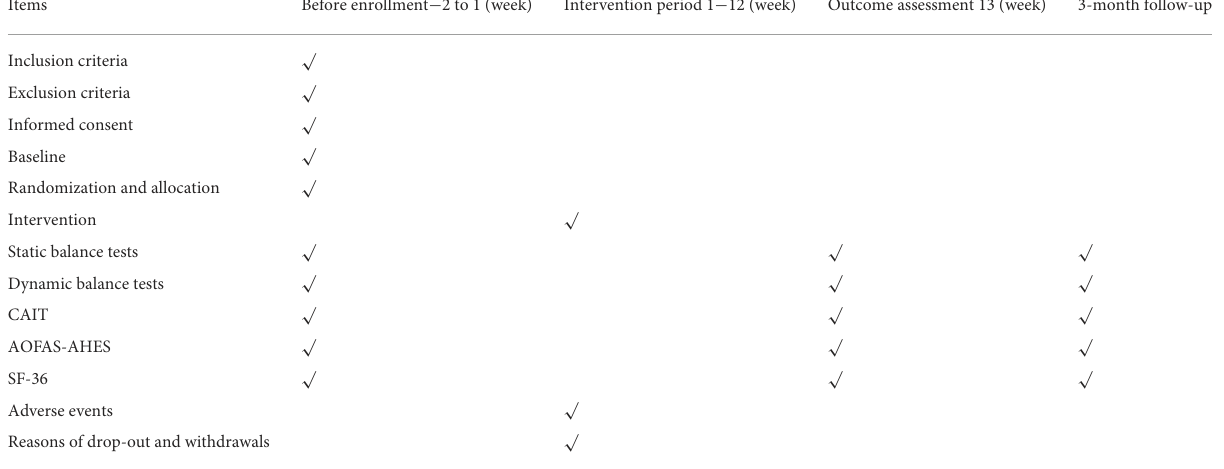
TABLE 1 Trial processes